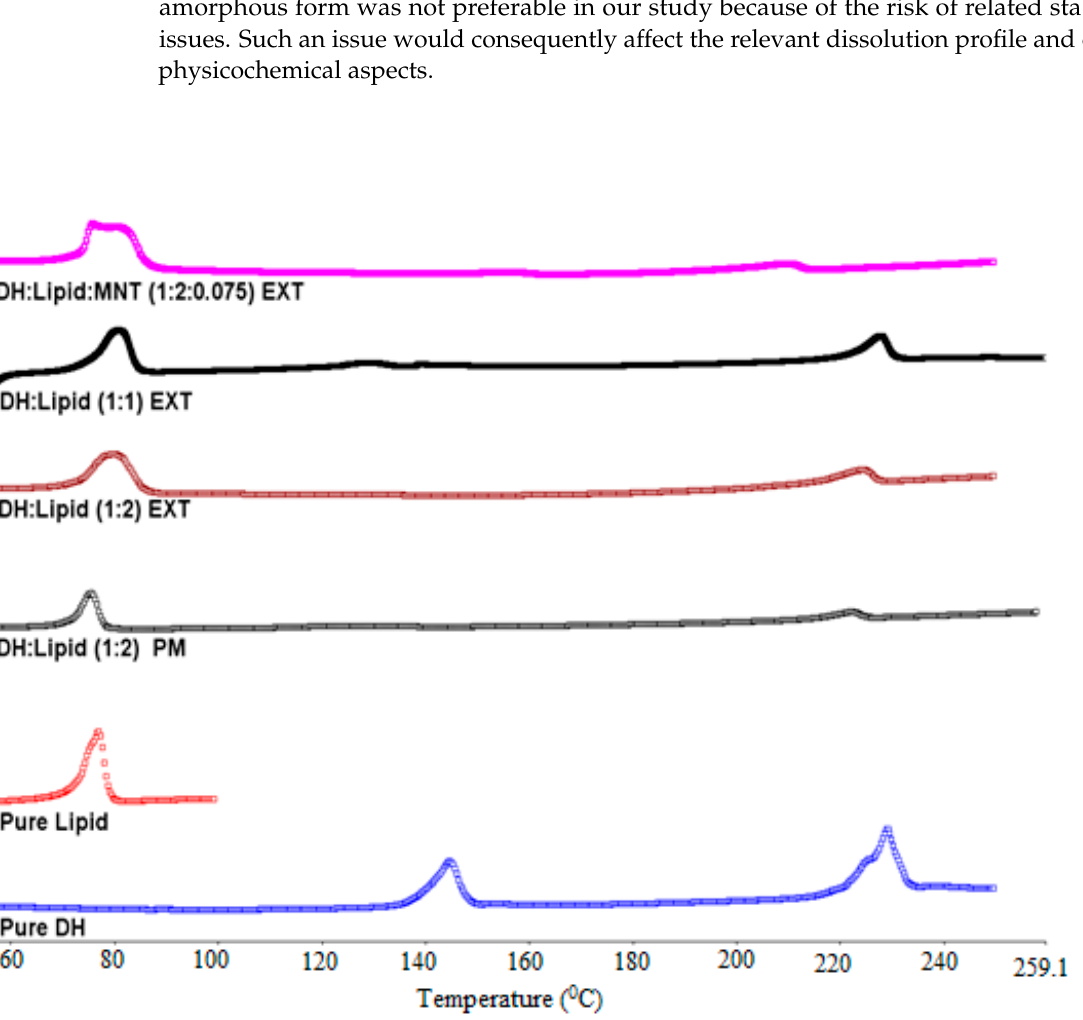
Figure 3. DH/C-888 DSC studies performed at temperatures of 30–250 °C and a heating rate of 20 °C/min.